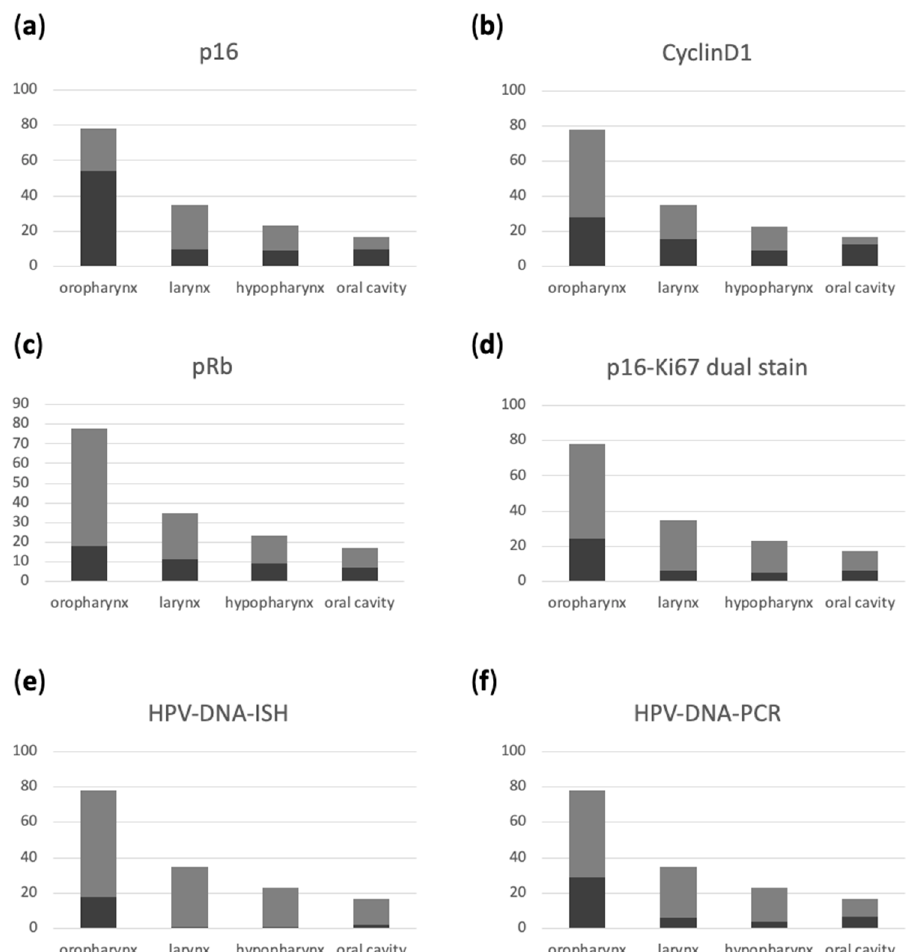
Figure 6. Expression pattern of HPV surrogate markers depending on anatomical localization of the primary tumor. Expression of p16 ( a ), Cyclin D1 ( b ), pRb ( c ), and results of p16-Ki67 dual stain ( d ), HPV-DNA-ISH ( e ), and HPV-DNA-PCR ( f ) delineated for oropharyngeal cancer ( n = 78), laryngeal cancer ( n = 35), hypopharyngeal cancer ( n = 23), and cancer of the oral cavity ( n = 17). In ( a – c ), immunohistochemical staining results with an IRS ≥ 7 are shown in black and staining results with an IRS < 7 are shown in gray. In ( d – f ), positive results are shown in black and negative results are shown in gray.